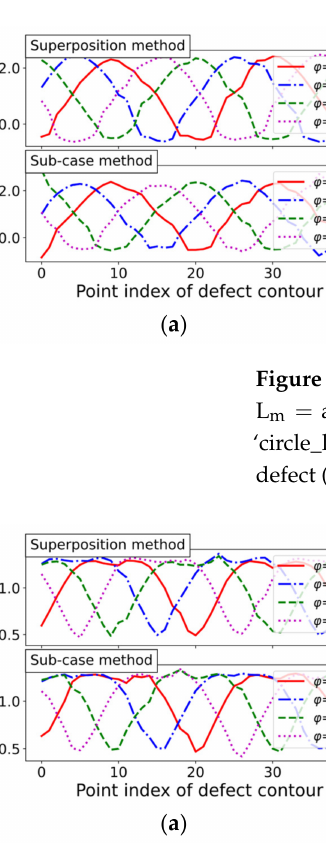
Figure 21. TCD Point Method stress course for three defect geometries at evaluation arc-length L m = 1 mm and incremental load step of ∆ ϕ = 10 ◦ : ( a ) Circular hole-in-plate (mesh ‘cir- cle_lin_R1mm_v1’); ( b ) Elliptical hole-in-plate (mesh ‘ellipsis_lin_rot0deg_v1’); and ( c ) Elongated defect (mesh